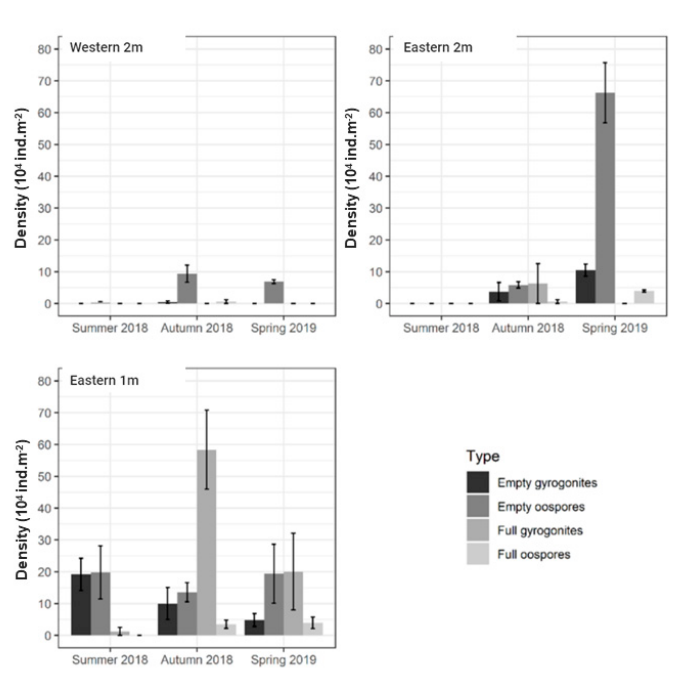
Figure 5. The seasonal dynamics of the mean ( ± standard deviation) density of Chara contraria/contraria group fructifications in the third profile of the study area. For the comparison, the profile was divided into sections according to the side of the lagoon shore (eastern and western) and the depth zone (1 and 2 m).